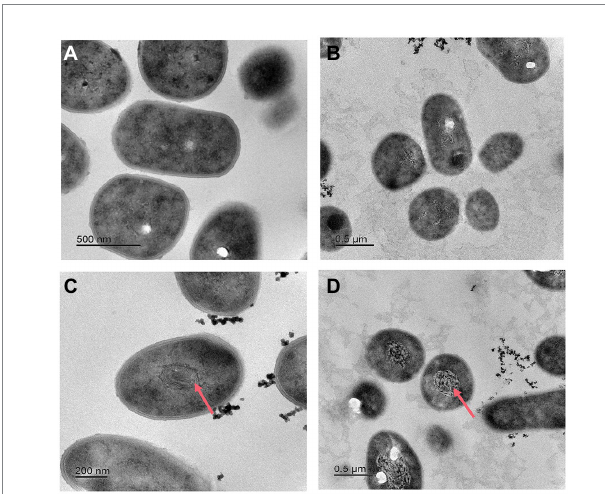
FIGURE 3 Transmission electron micrographs of strain 24S4–2 in various mediums. (A) R2A medium, (B) ammonium as the sole nitrogen source medium, (C) nitrate as sole nitrogen source medium, and (D) nitrite as sole nitrogen source medium.